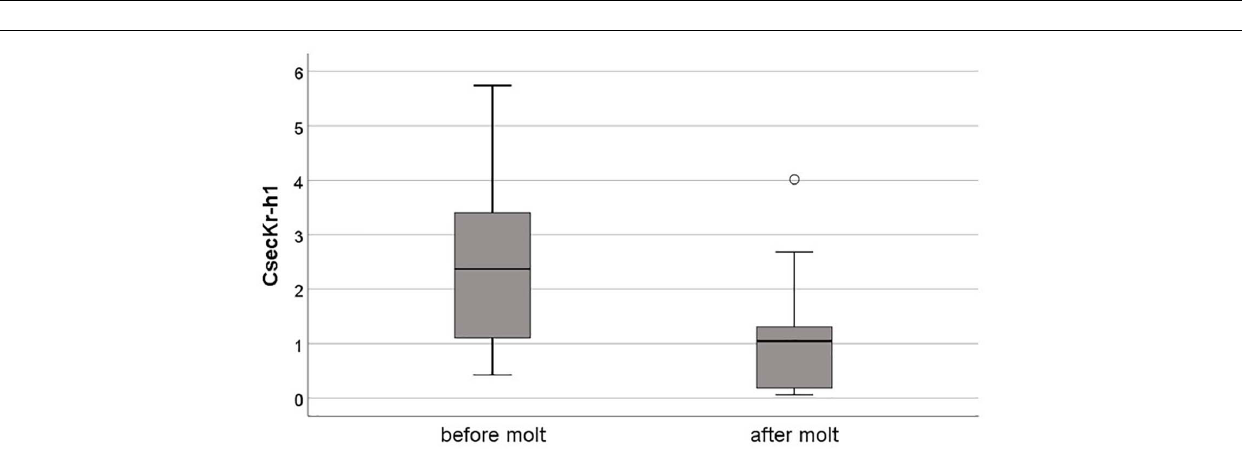
FIGURE 4 | Relative expression of the CsecKr-h1 before and after a molt in untreated individuals. The expression of this early response gene of JH signaling was significantly higher before than after a molt. Shown are boxplots with median, quartiles, minimal and maximal values, and outliers (open circle), the later are cases that have values at least three times the height of the